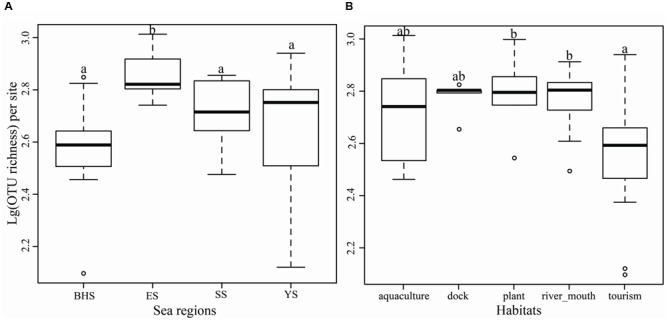
Operational taxonomic units richness per site in four sea regions (A) and five types of habitat (B) as demonstrated by boxplot with median and 95% confidence intervals displayed. Bars without shared letters indicate significant differences at the level of P-value = 0.05.